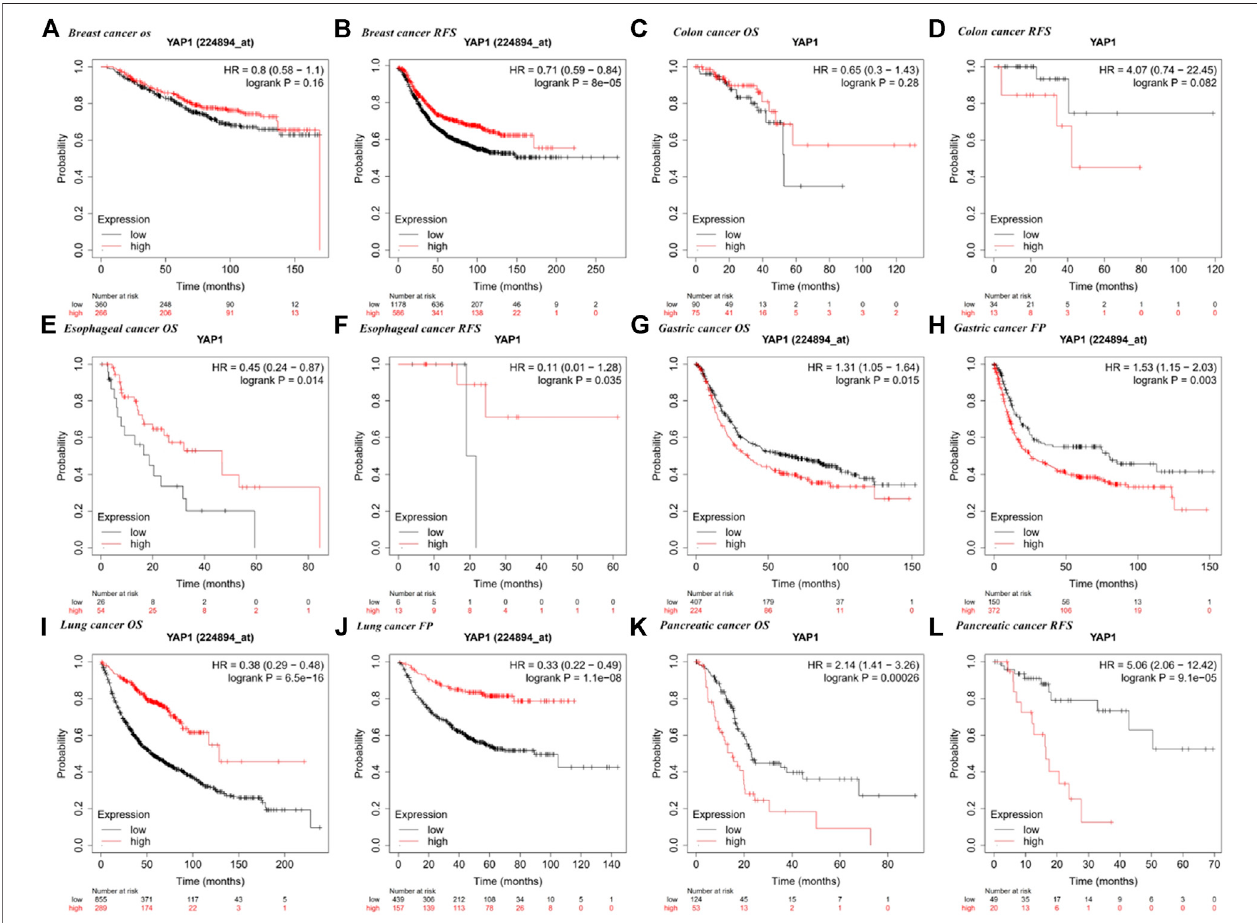
FIGURE 4 | Kaplan – Meier survival curves for high and low YAP1 expression in different types of cancer based on the Kaplan – Meier plotter database. OS, overall survival; DFS, disease-free survival; RFS, relapse-free survival; DSS, disease-speci fi c survival. DMFS, distant metastasis-free survival. FP, fi rst progression.